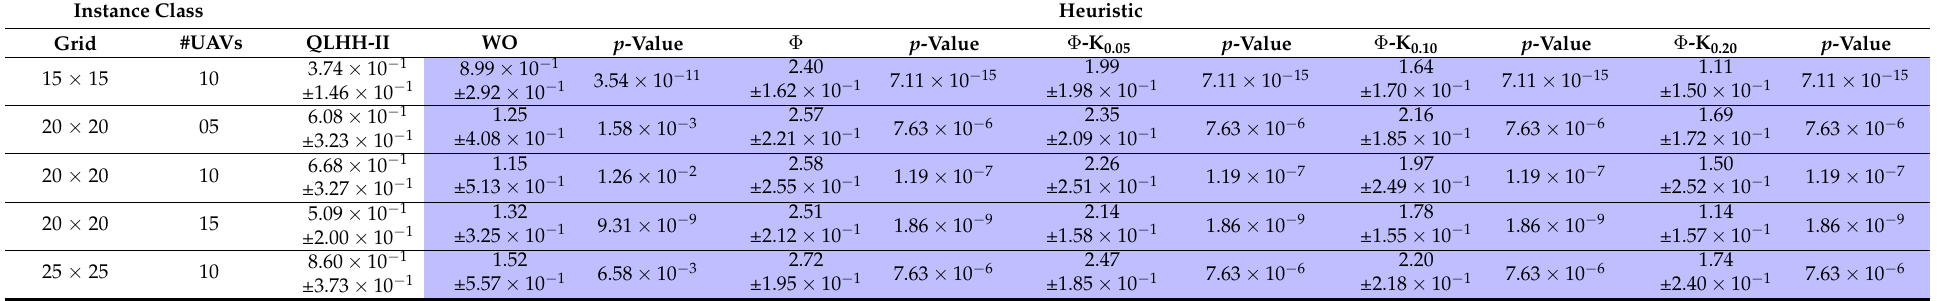
Table 4. Comparison between heuristics according to IGD.